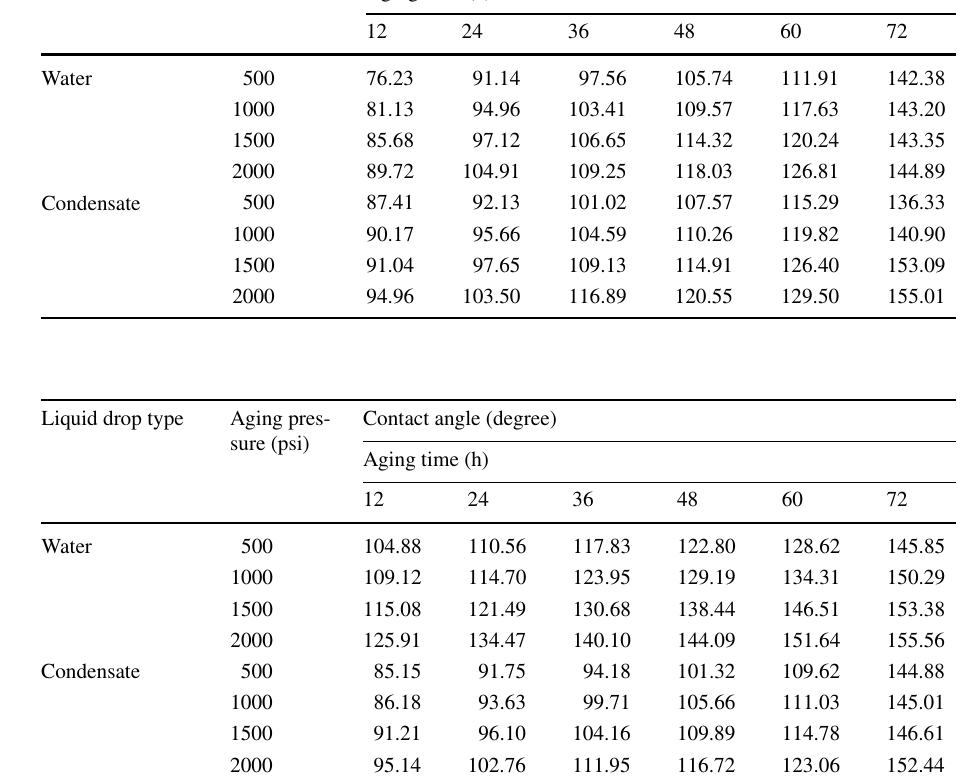
information from contact angle tests from placing the water and condensate drops in the presence of the air on aged carbonate sections in R134A gas at 70 °C and different pressures of aging duration